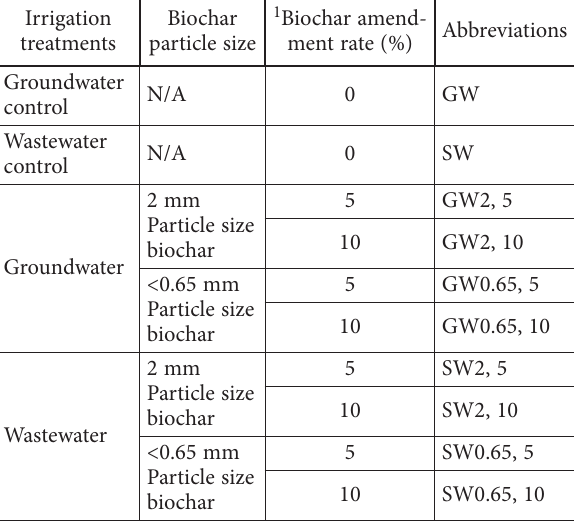
Table 1. Experiment layout and abbreviations of